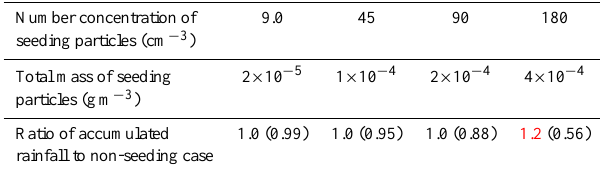
Table 4. Ratios of seeded-case to non-seeded case accumulated sur- face rainfall averaged over the domain at 60min. Seeding of shal- low convective cloud is conducted with salt micro-powder of dif- ferent concentrations. A ratio indicating increase is colored red. Ratios of seeded-case to non-seeded-case (665cm − 3 ) cloud droplet number concentrations at 50m above the base of the cloud center at 11.5min are shown in parentheses.